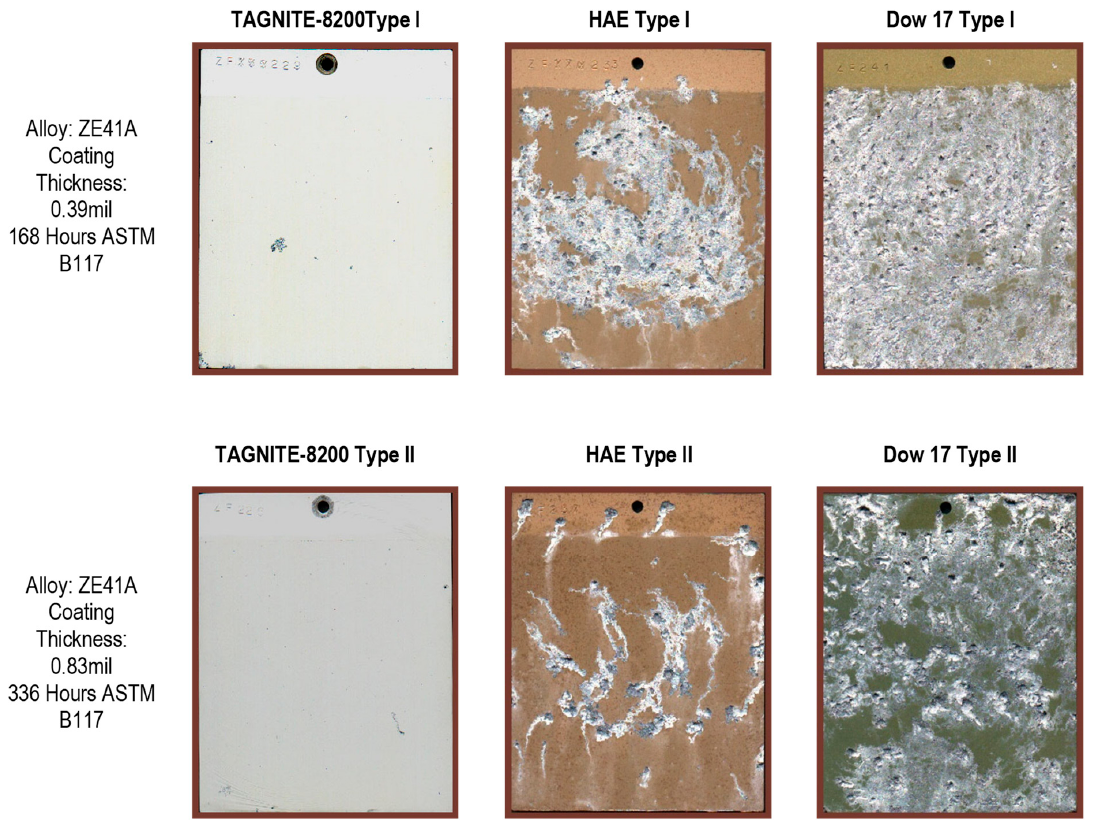
Figure 8. Magnesium test plates after TAGNITE-8200, HAE, and Dow 17 treatments and exposure to salt spray (ASTM B117) for 168 (Types I) and 336 (Types II) hours. Adapted from [79].